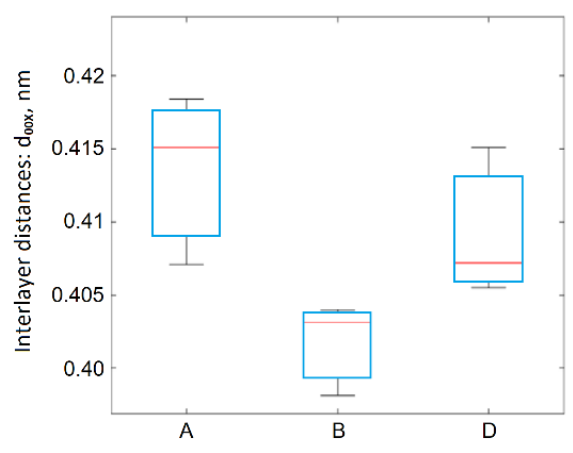
Figure 9. Box plots for the oxygen concentration ( a ) and carbon/oxygen ratios ( b ) depending on the precursor material. XRD studies confirmed the graphite structure reconstruction in the rGO. Interlayer distances decreased from ~0.8 nm (d 001 band) in the GO to ~0.4 nm (d 00X band) in the rGO (Figure 10). The oxidation method’s influence affected the interlayer distances in the rGO, and this influence was statistically significant. Based on observations, it can be affirmed that reduced graphene oxides obtained from graphites oxidized by method A showed the highest degree of structural defects, while those obtained by method B were characterized by the lowest degree of structural defects. Such a low degree (for reduced graphene oxides prepared using method B) indicates that reconstruction of the graphite structure was increased.